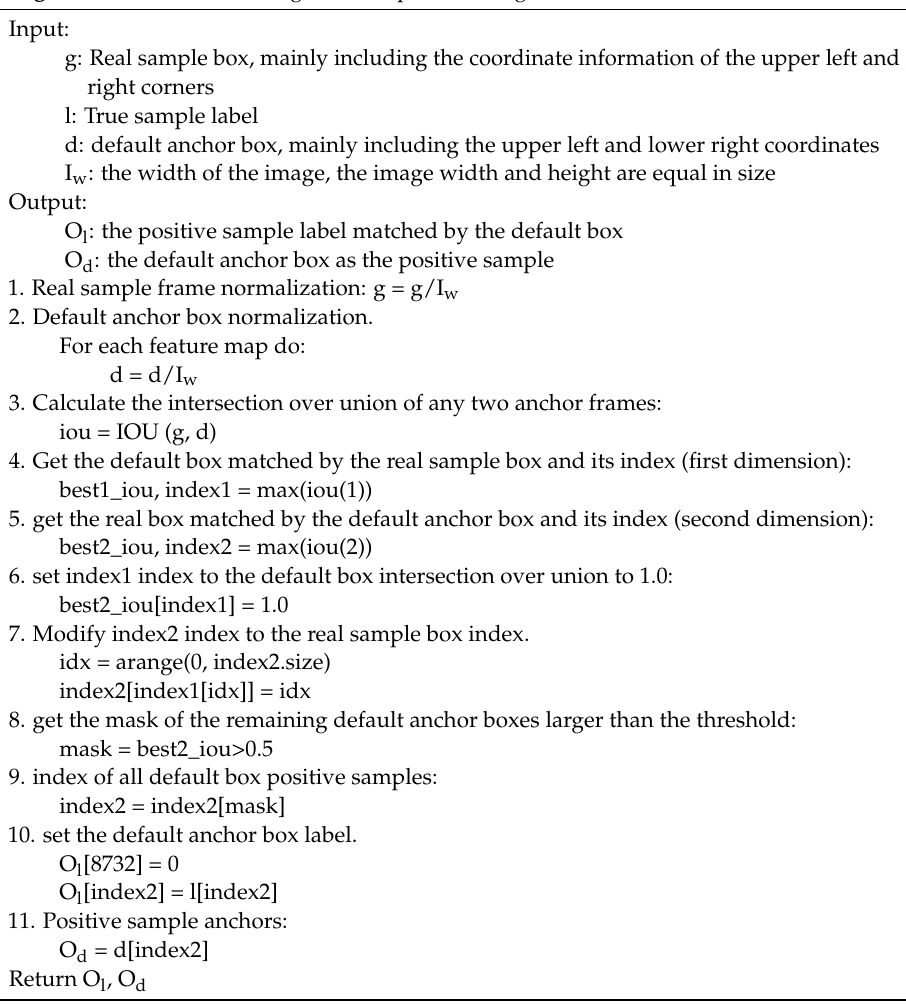
Algorithm 1 Positive and negative sample